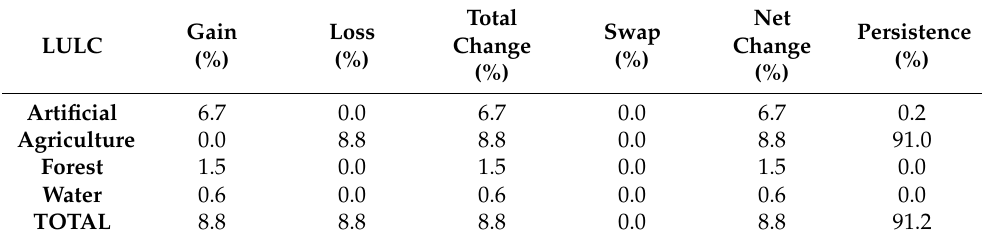
Table 5. Land use change parameters, period of time: 1956–2018. Miranda